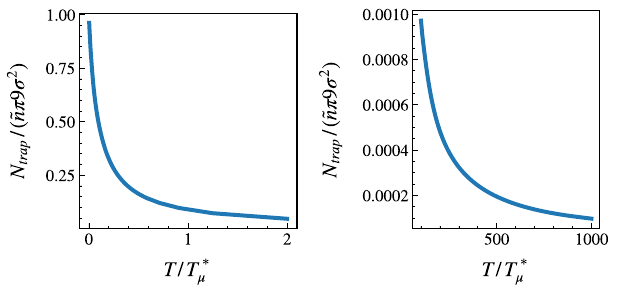
FIG. 15. Fraction of MDM molecules trapped in the beam as a function of T=T (cid:3) μ , for T from 0 to 2 T (cid:3) μ (left) and through 1000 T (cid:3) μ (right). For this calculation we assumed R b ¼ 3 σ